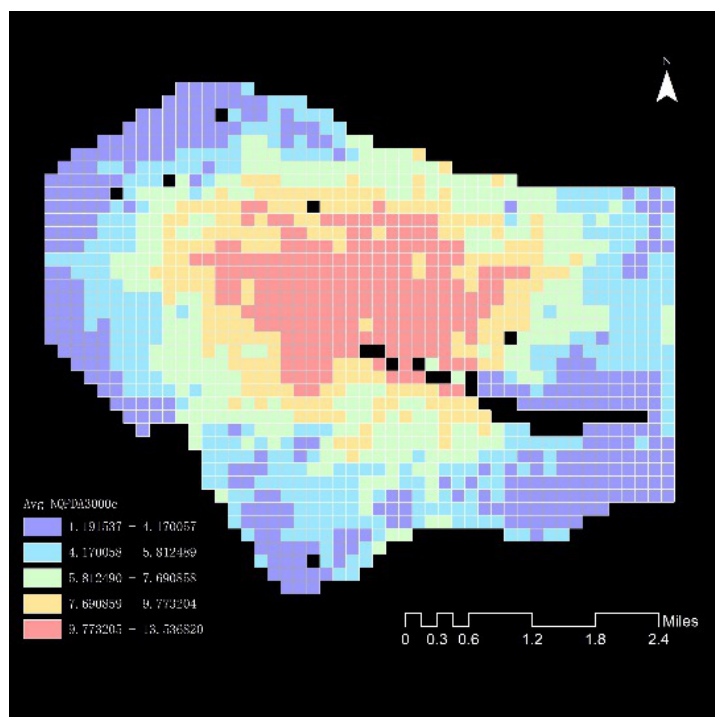
Fig. 11 Fishing net graph of the regional closeness of 5000m